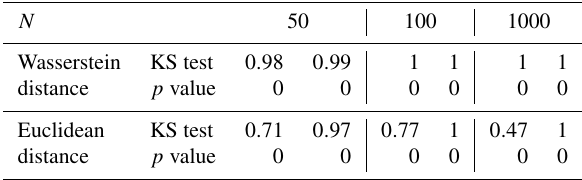
Table 1. Kolmogorov–Smirnov test applied between distribution (resp., right) box on snapshots of size N